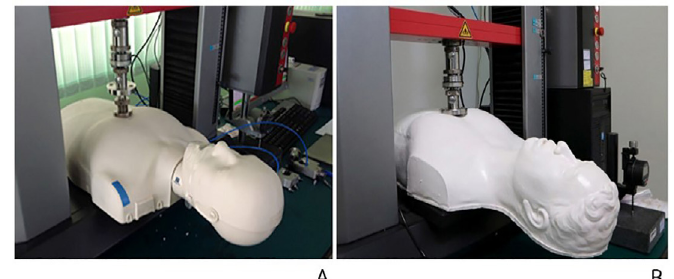
Figure 4. Prestan adult manikin (A) and natural rubber manikin (B).